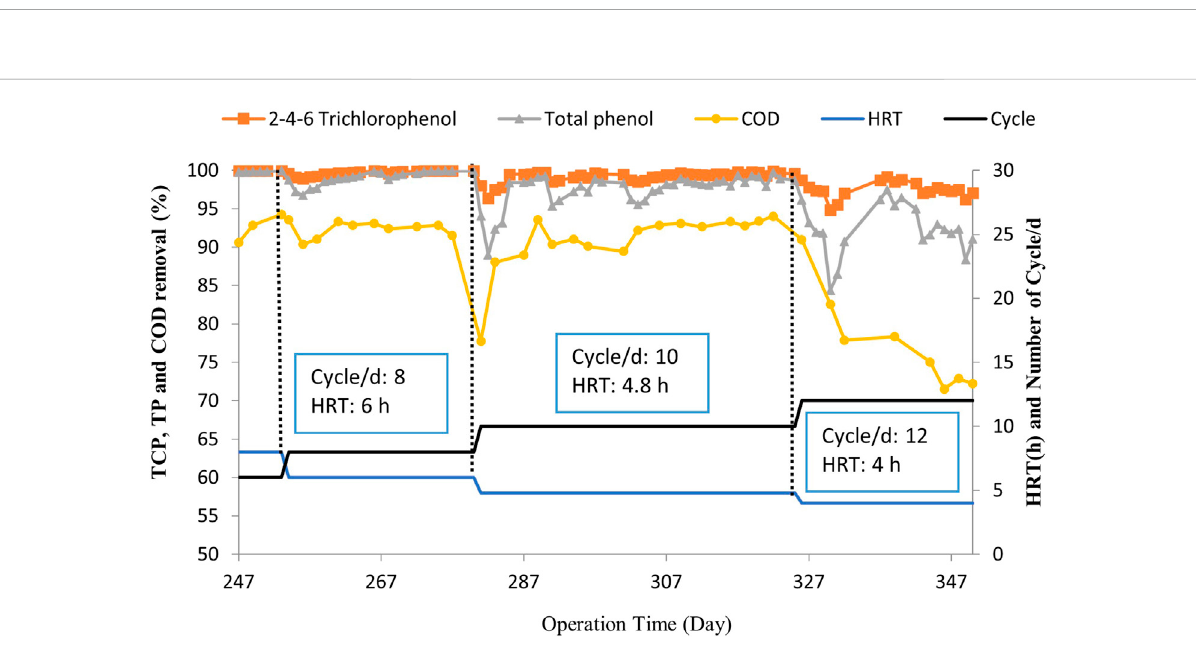
FIGURE 5 The effect of the number of cycles on the